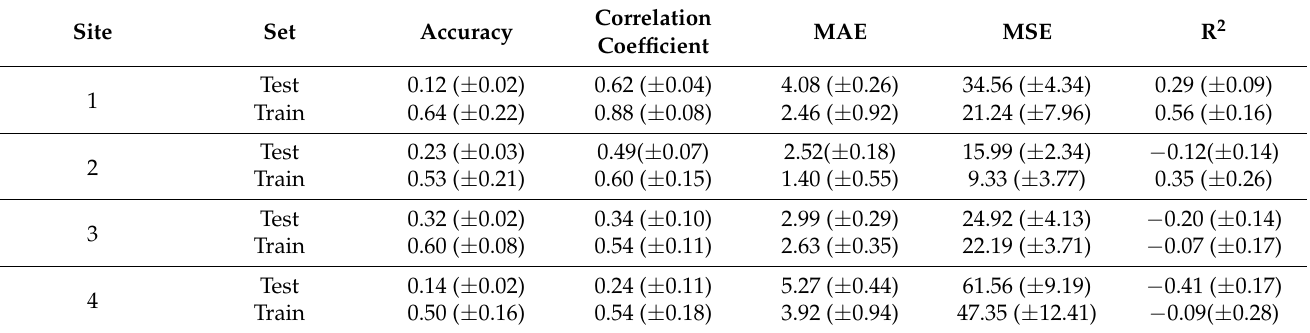
Table 9. Correlations obtained using GridSearchCV.